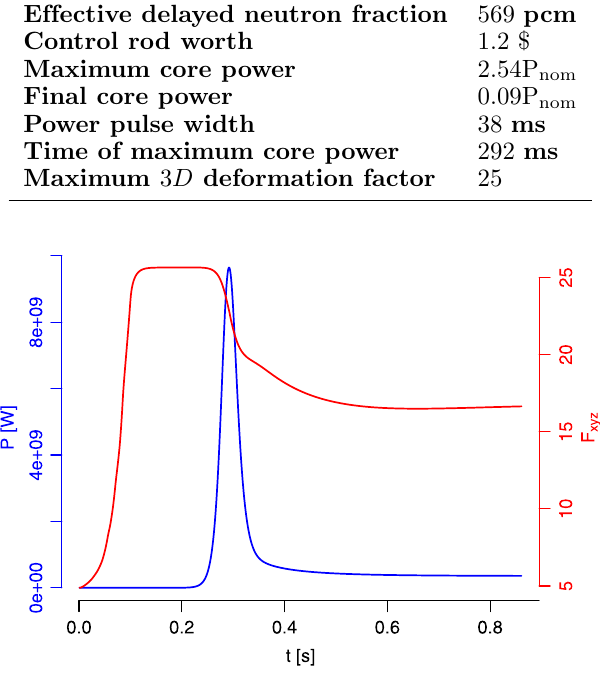
Fig. 4. Integral power and F xyz deformation factor evolution for the reference